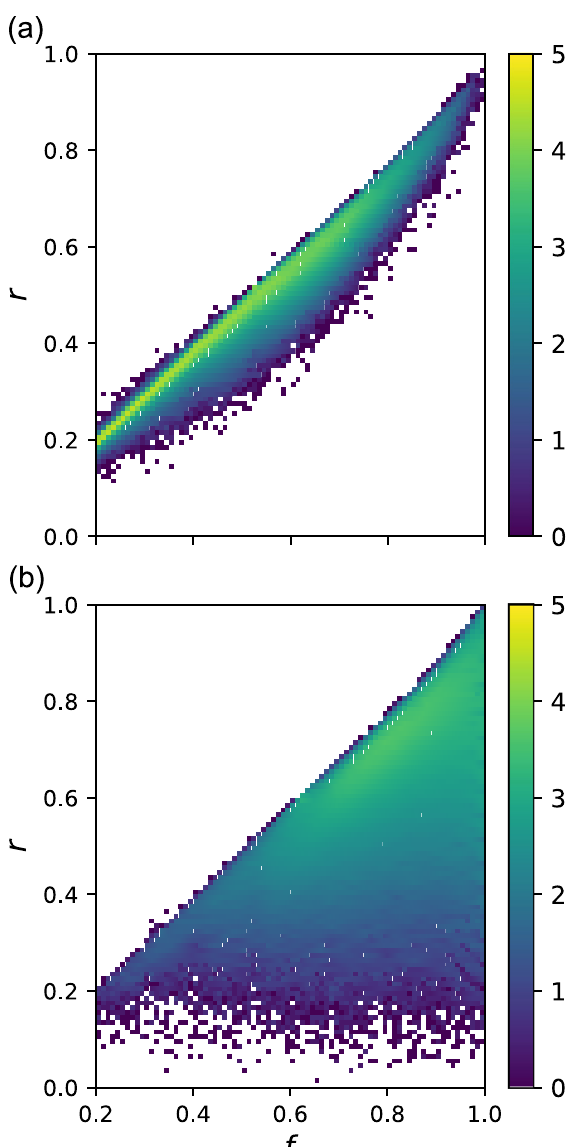
Fig 7. Number distribution of fitness f and robustness measure r obtained via random sampling. (a) the monostable GRNs (b) the bistable GRNs. Both f and r are divided into bins of width 0.01. Color of each bin indicates the base 10 logarithm of the number of GRNs. No GRN was found in white bins. The strict criterion was used to determine bistability. Note that the total number of GRNs in each bin of f is about 50000 irrespective of the value of f